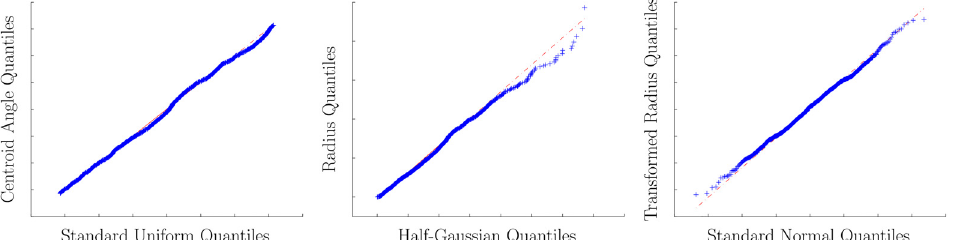
Fig 2. Quantile-Quantile (Q-Q) plots of the angles versus a uniform distribution (left), radii versus a half-Gaussian distribution (middle), transformed radii (see Sec. 3.3) versus a normal distribution